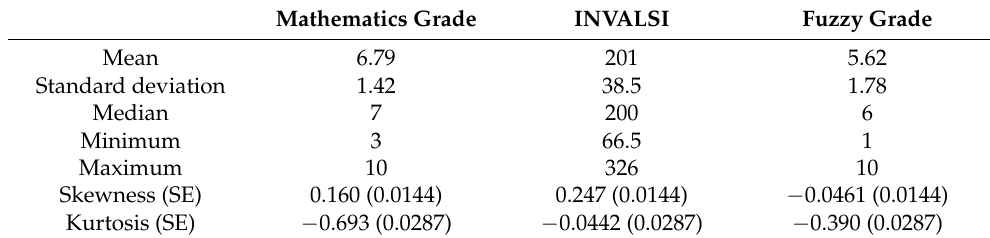
Table 6. Descriptive statistics for 8th grade